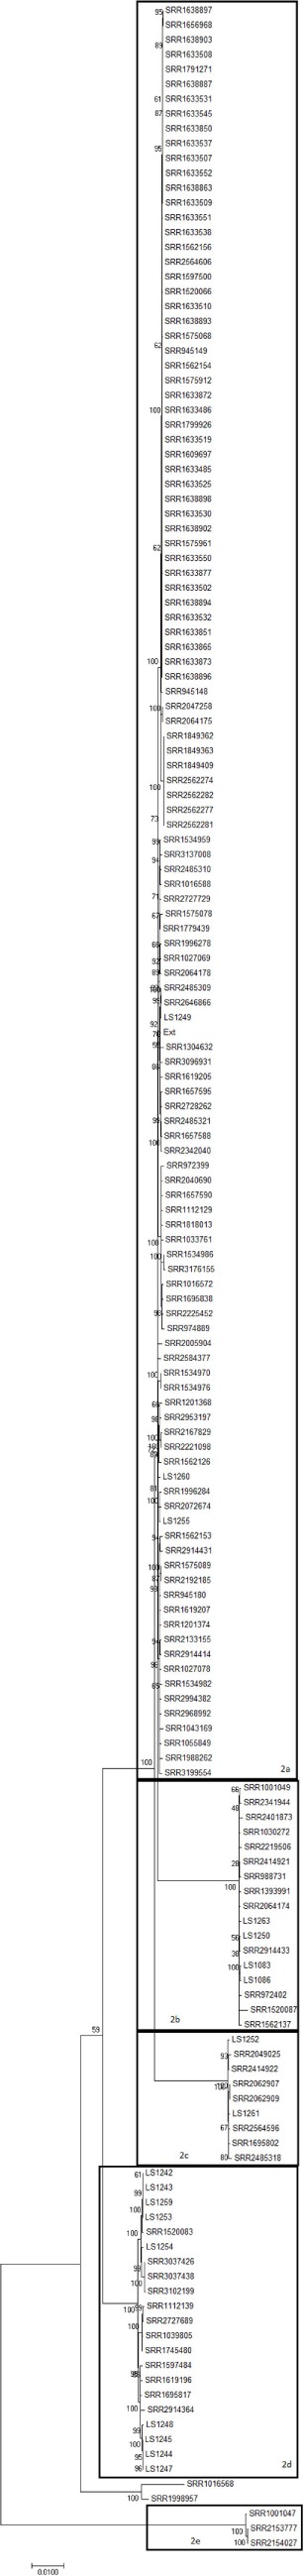
A maximum likelihood tree of members of 4bV Clade 2 derived from SNP alignment file generated using the CFSAN SNP Pipeline with bootstrapping (n = 1,000). Strains linked to specific outbreaks are renamed as noted in Table S1 in Supplementary Material for ease of reference. Subclades within Clade 2 are indicated. The scale bar indicates distance as assessed by the Tamura–Nei method.